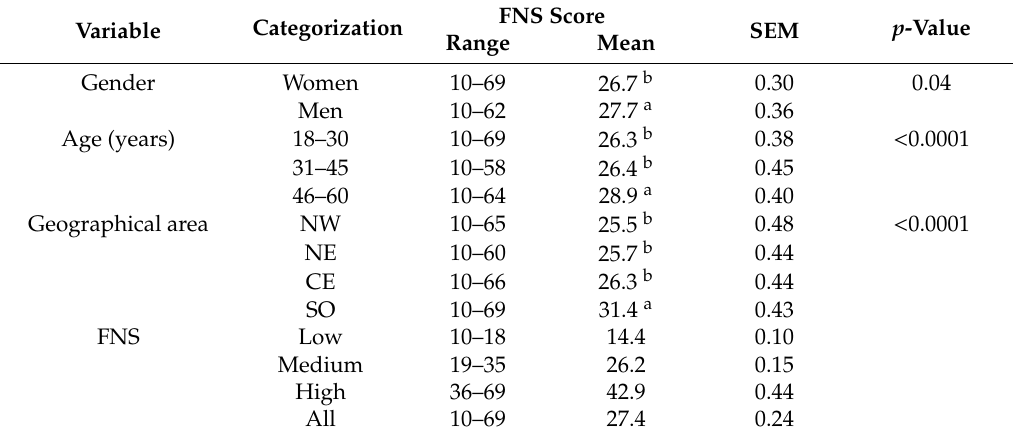
Table 3. E ff ect of gender, age, and geographical area (NW = North West, NE = North East; CE = Center; SO = South and Islands) on FNS (Food Neophobia Scale) score and details of the participants grouped according to food neophobia level (low, medium, and